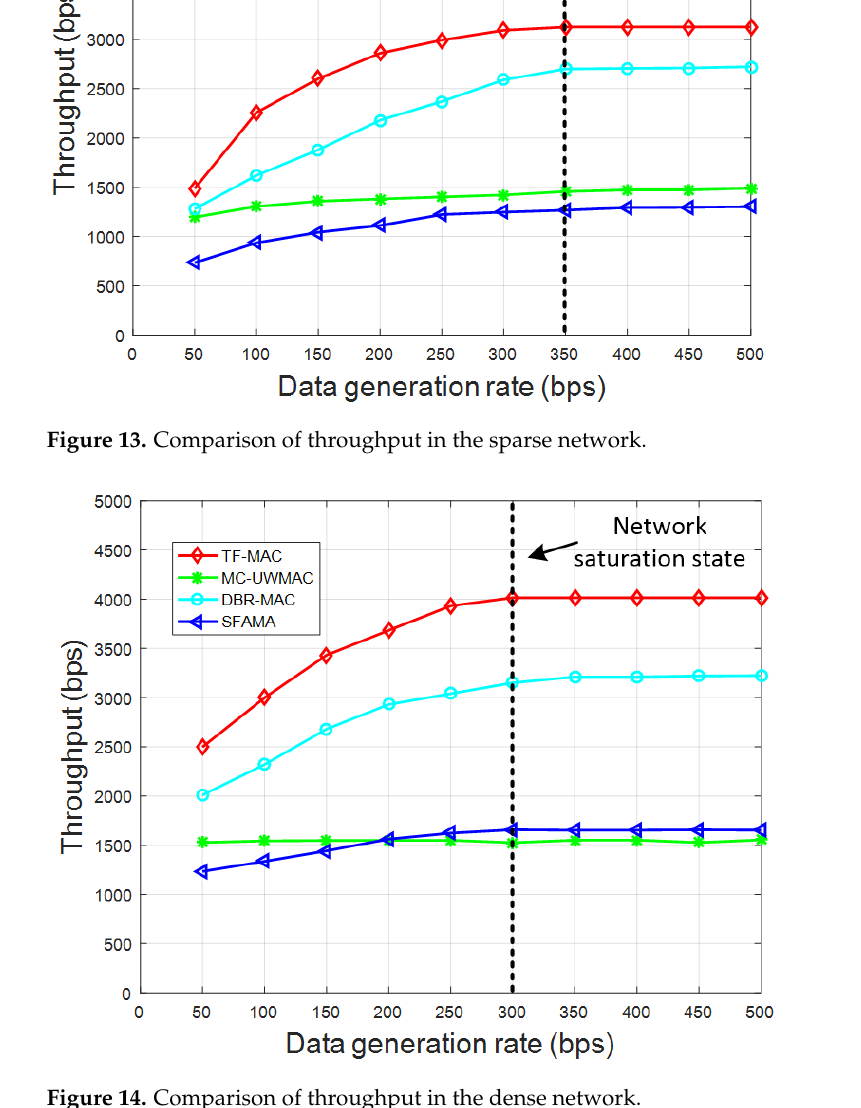
Figure 14. Comparison of throughput in the dense